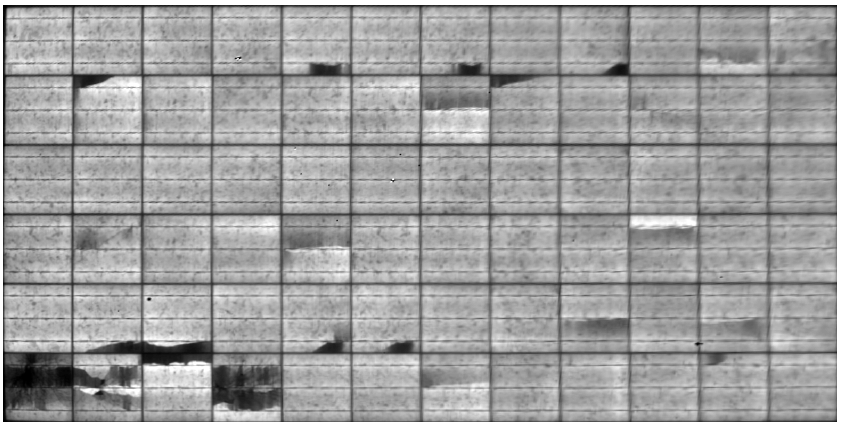
Figure A4. DaySy ™ electroluminescence (EL) image after distortion correction and perspective transformation. This image can be used for further automated image processing